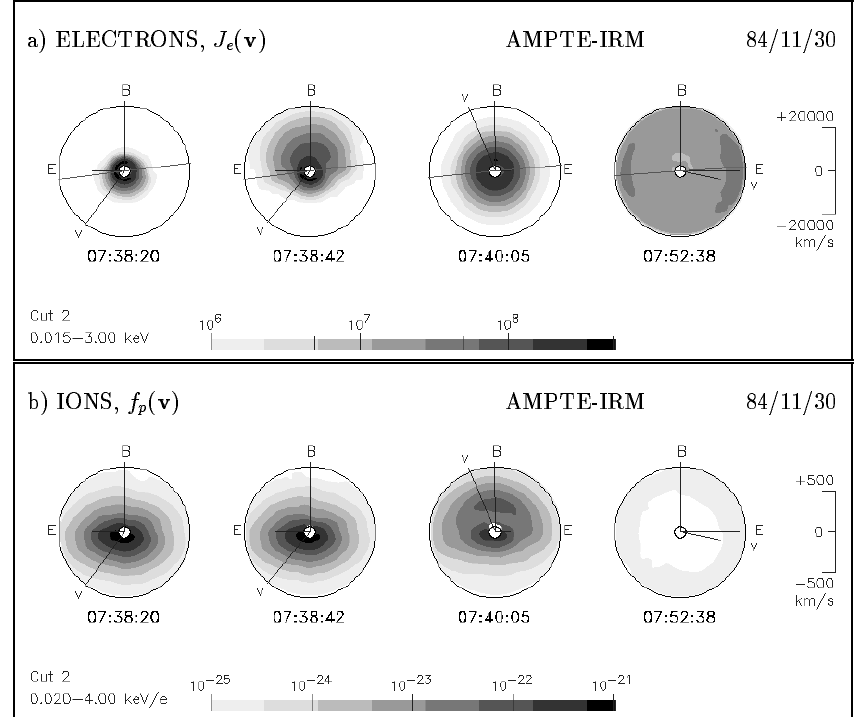
Fig. 9. Ion distributions in the energy range of 20eV–4keV and electron dis- tributions in the range of 15eV–3keV measured on 30 November 1984. The format is the same as in Fig.